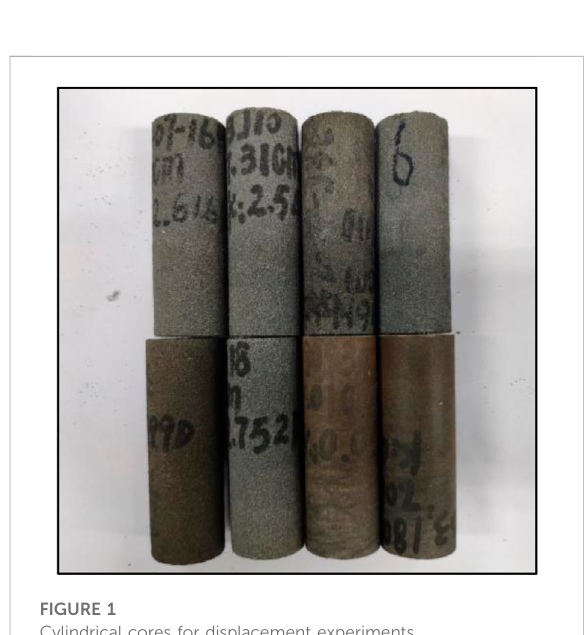
FIGURE 1 Cylindrical cores for displacement experiments.